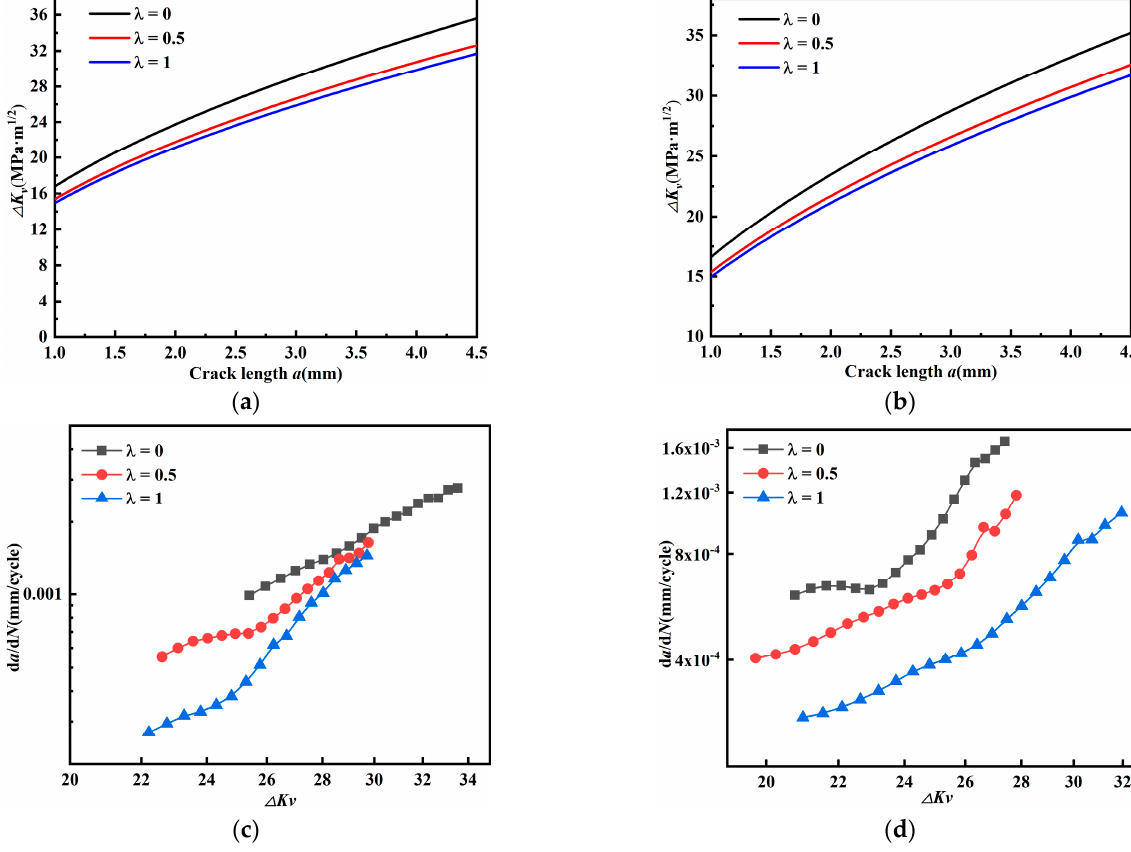
Figure 17. Relationship between crack length, equivalent stress intensity factor amplitude and da/dN . ( a ) Relationship between a and △ K v ( β = 60°), ( b ) relationship between a and △ K v ( β = 45°), ( c ) relationship between △ K v and da/dN ( β = 60°), and ( d ) relationship between △ K v and da/dN ( β = 45°).